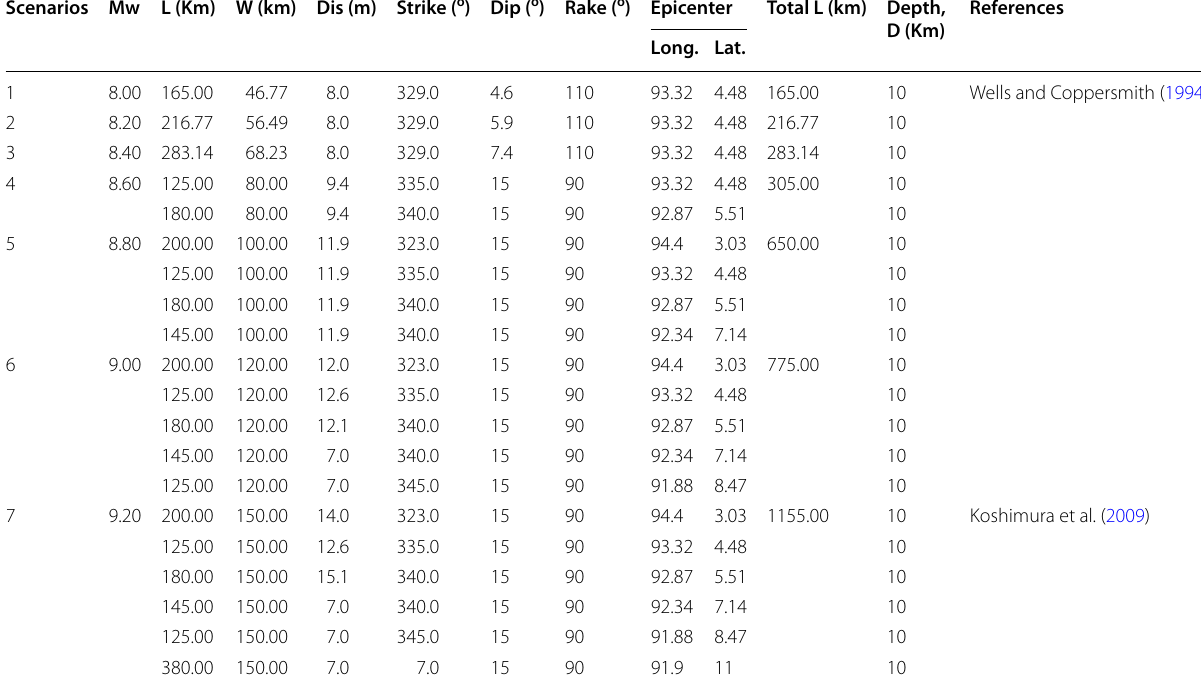
Table 1 Tsunami scenario based on fault parameters Scenarios Mw L (Km) W (km) Dis (m) Strike ( o ) Dip ( o ) Rake ( o )